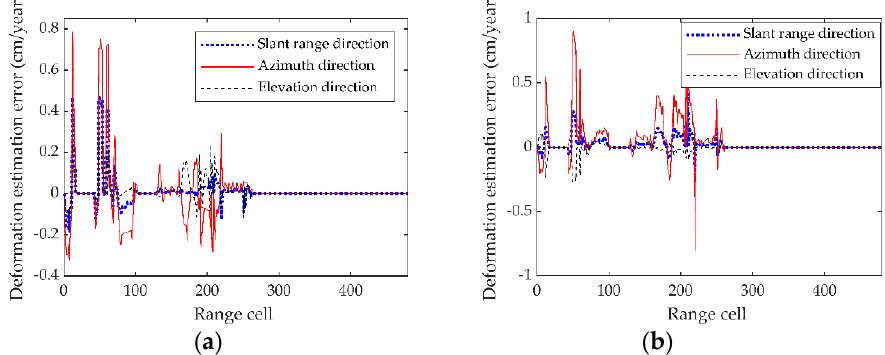
Figure 14. The estimation errors of 3-D deformation velocities for the scatterers located in the slice of Figure 12a. ( a ) dominant scatterer. ( b ) secondary scatterer.